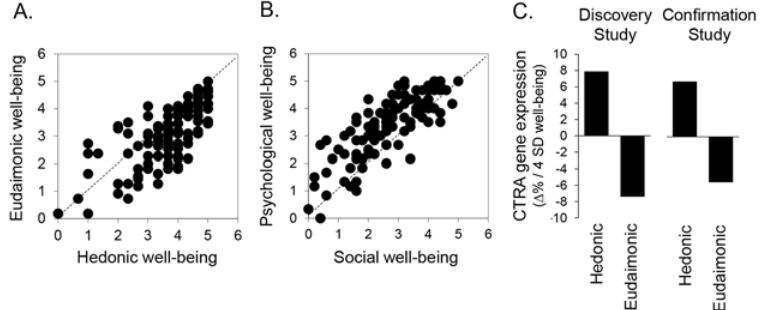
Fig 1. Well-being and CTRA gene expression. (A) Relationship between MHC-SF hedonic and eudaimonic well-being domain scores (2-d representation). (B) Relationship between psychological well- being and social well-being scores (the 2-d eudaimonic domain within the 3-d well-being representation). (C) Point estimates of average association coefficients relating range-spanning variations in hedonic and eudaimonic well-being scores [-2 SD, +2 SD] to unstandardized (log 2 metric) gene expression values for 52 CTRA indicator genes (reverse scoring 34 inverse components) in the discovery study (n = 76) and confirmation study (n = 122). Log 2 association coefficients are transformed to % difference in average CTRA transcript abundance to facilitate interpretation.